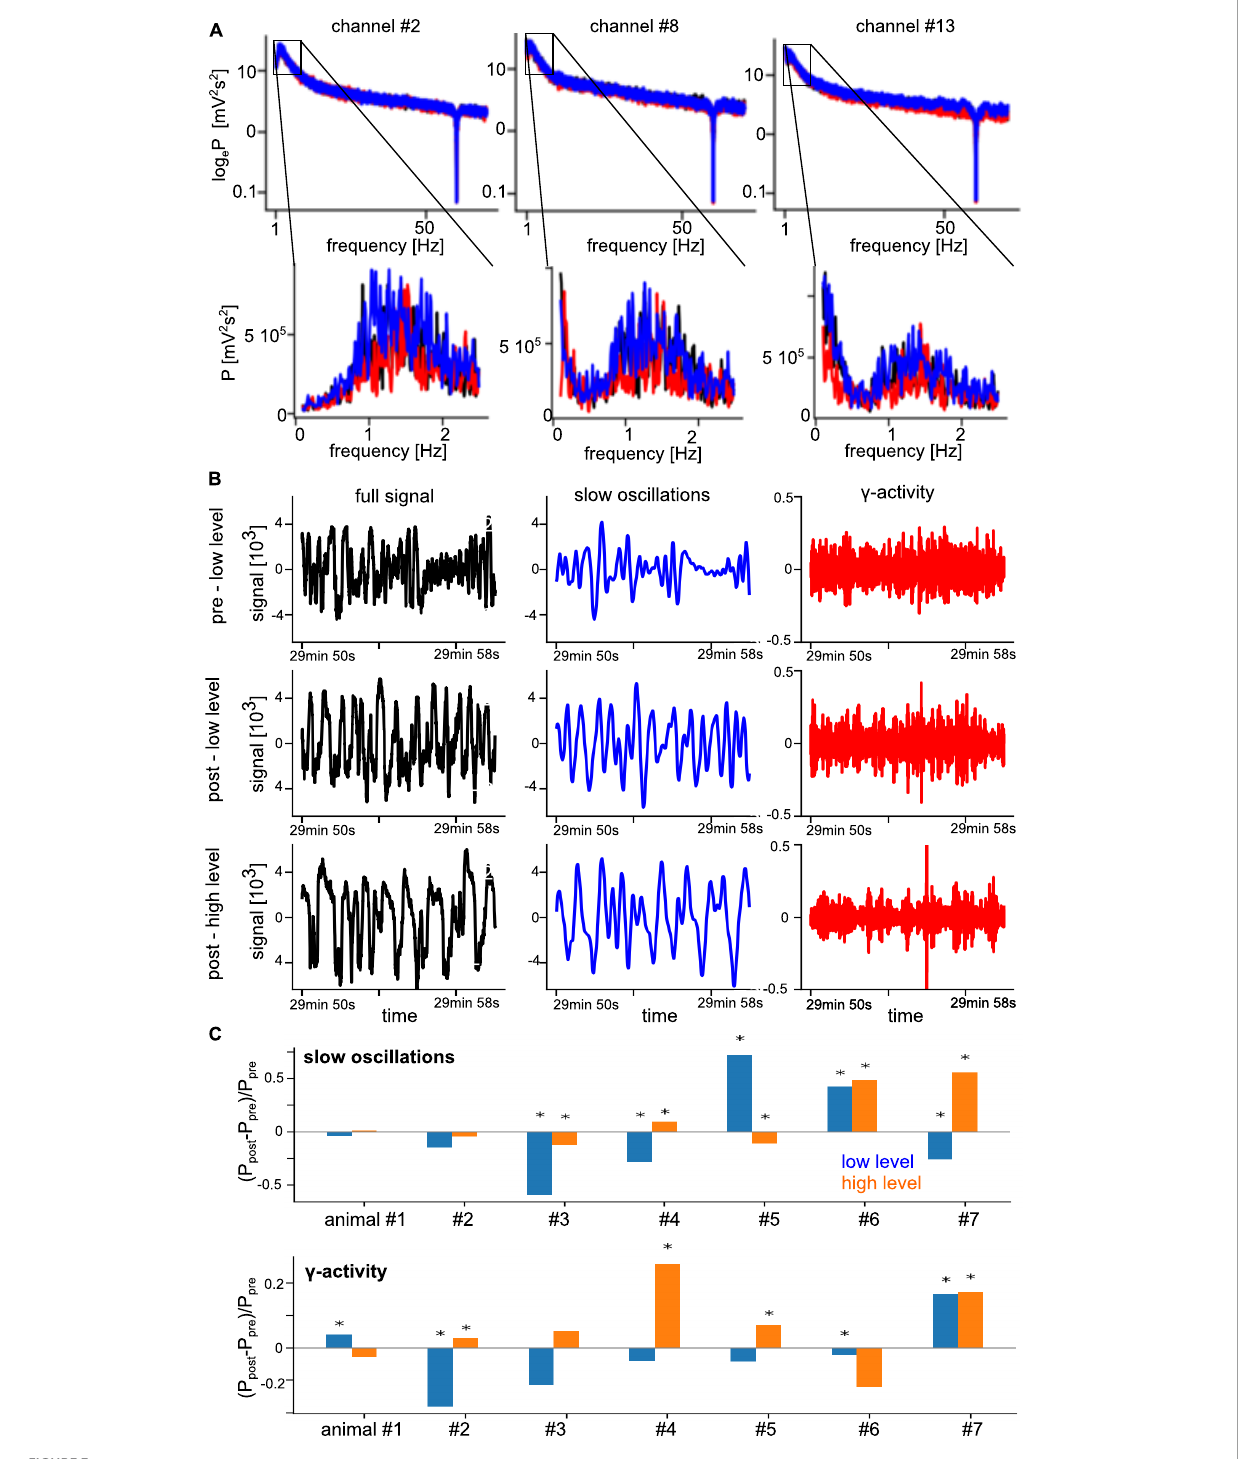
FIGURE3 Prominent spectral activity at slow oscillations ( ∼ 1 Hz) and in the γ -frequency band. (A) Power spectral density of three selected electrode channels before stimulation (black line), during stimulation (red line), and after stimulation (blue line) from animal #7 at medium anesthesia level. (B) Time series of a typical signal (black), band pass-filtered signal about 1 Hz (blue), and γ -activity (red) in the pre- and post-stimulation phase at low anesthesia level (top row and center row) and in the post-stimulation phase at high anesthesia level (bottom row) from the same animal. (C) Relative change of global spectral power of slow oscillations (top panel) and γ -activity (bottom panel) before (P pre ) and after (P post ) stimulation at low (blue) and high (orange) anesthesia levels. Global power is defined as the median power value over all LFP channels in the respective frequency band. Significant changes between pre- and post-stimulation were tested by a pairwise non-parametric Wilcoxon test. *Significant differences are marked with asterisk ( α =